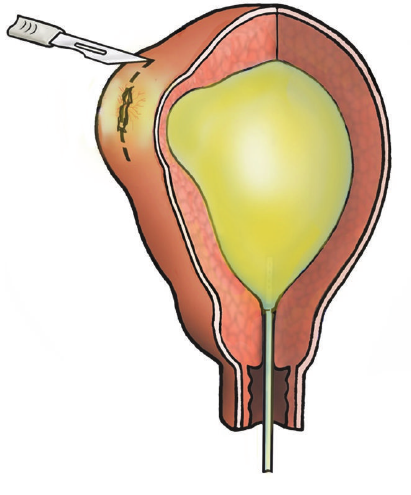
Figure 1: A size 10 Foley’s catheter was inserted into the uterine cavity, distended with 10mL of methylene blue, and left in situ. At laparotomy, neovascularisation that radiated like spider nevi was observed in the right cornu where only the serosal surface of the uterus separated the intrauterine balloon without any intervening myometrium. It was evident that this site would have been the site of previous cornual rupture forming an endometrial-peritoneal